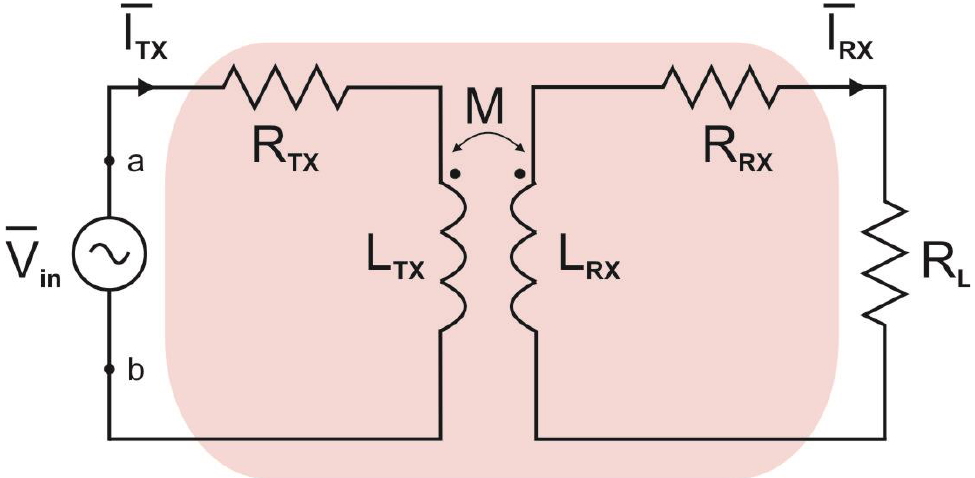
Figure 3. Simplified electrical equivalent circuit of WPT.